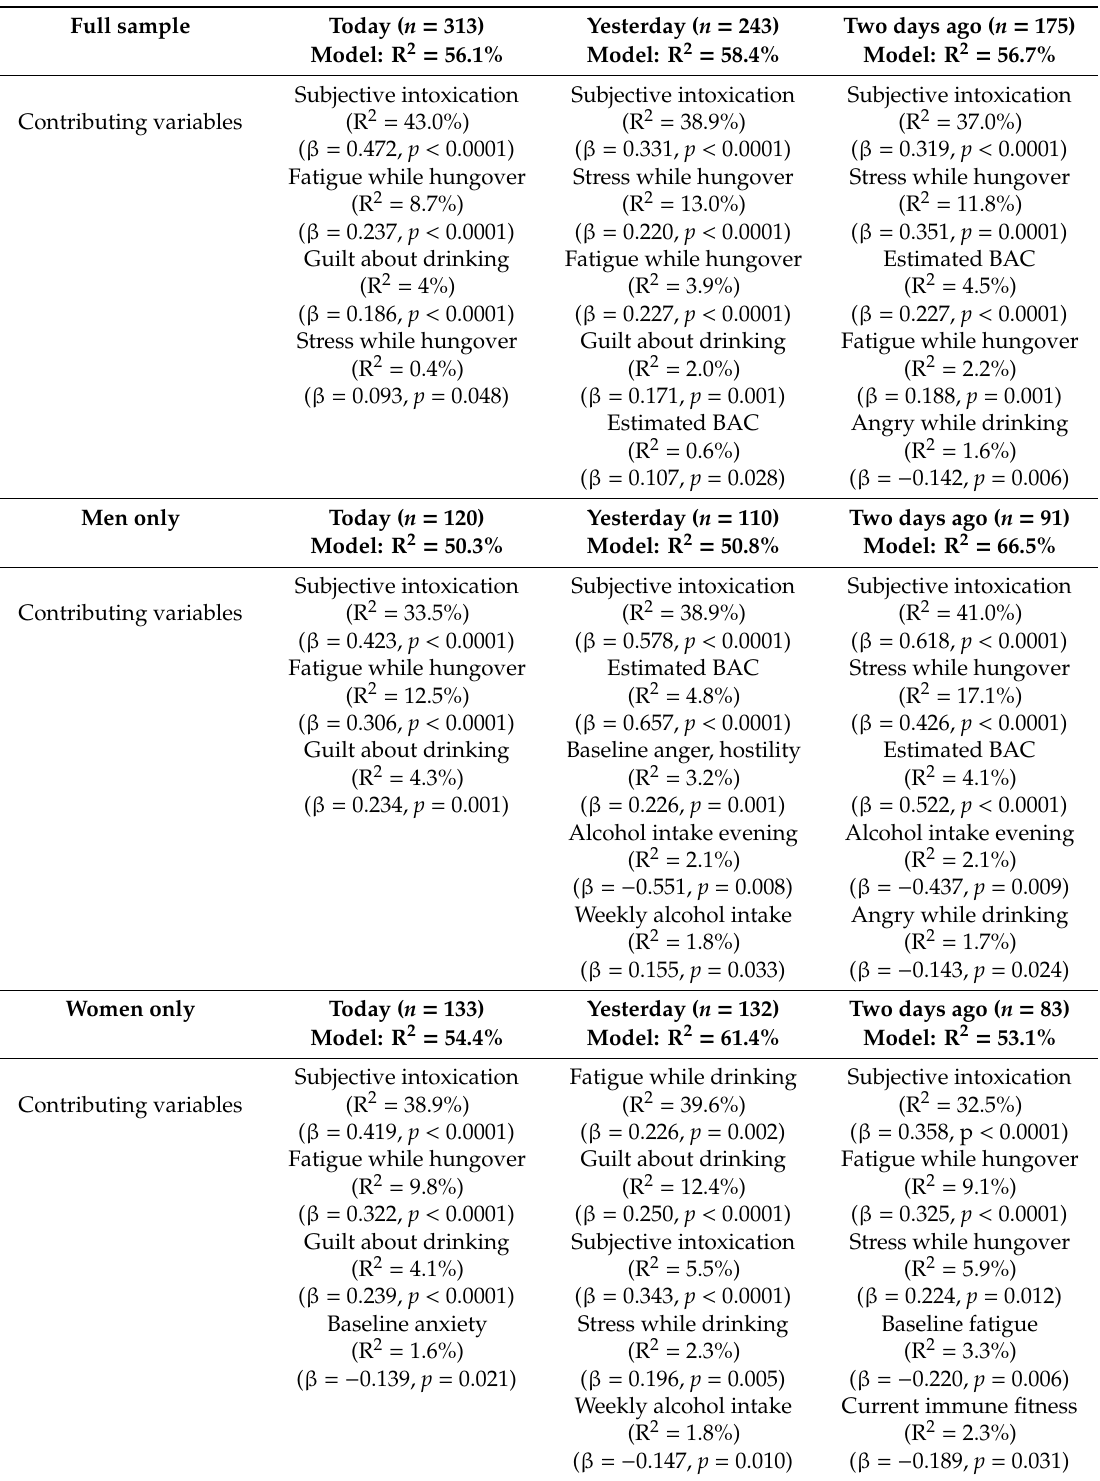
Table 4. Significant predictors of hangover severity (including next-day